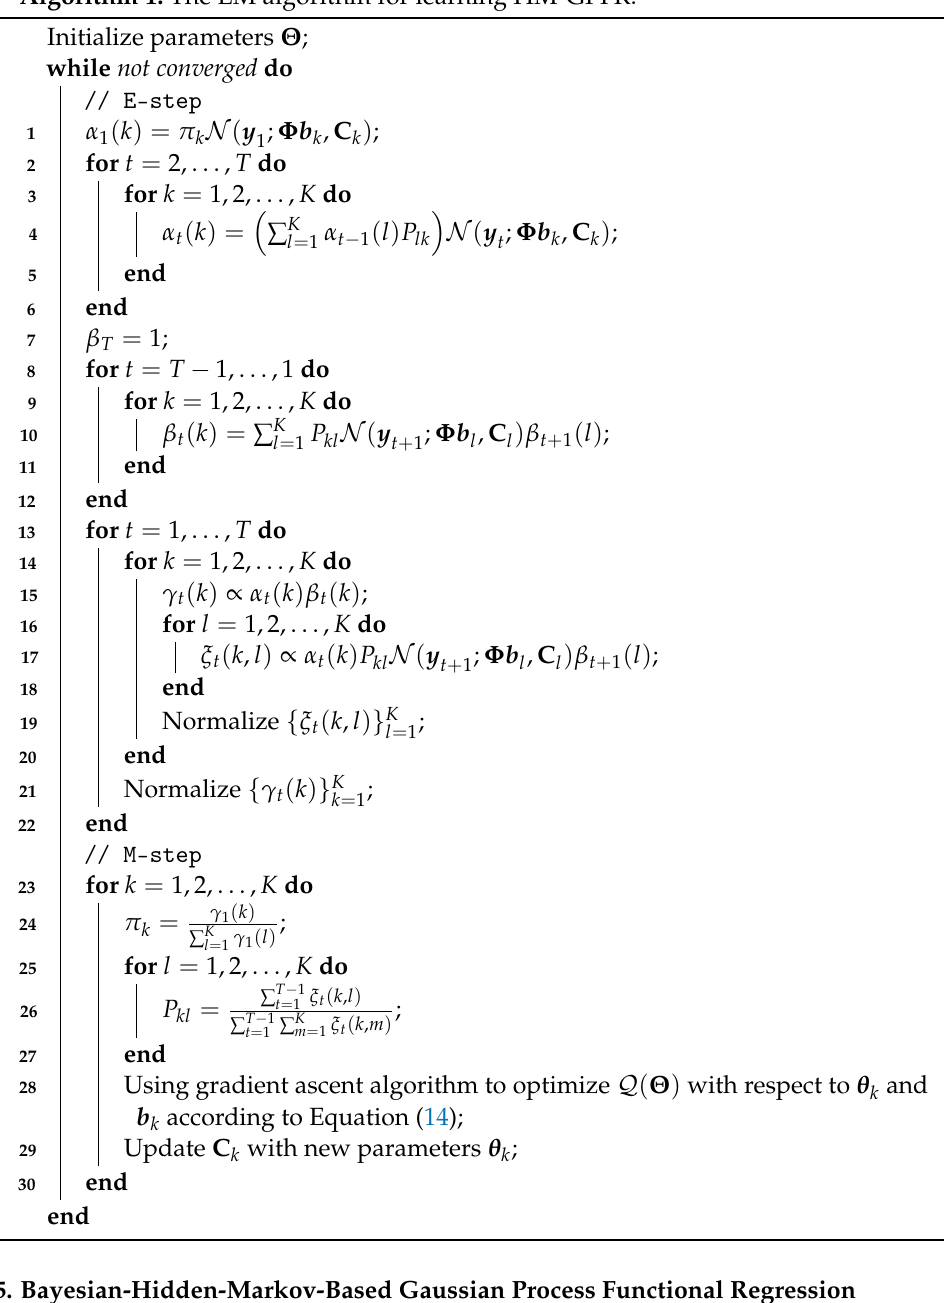
Algorithm 1: The EM algorithm for learning